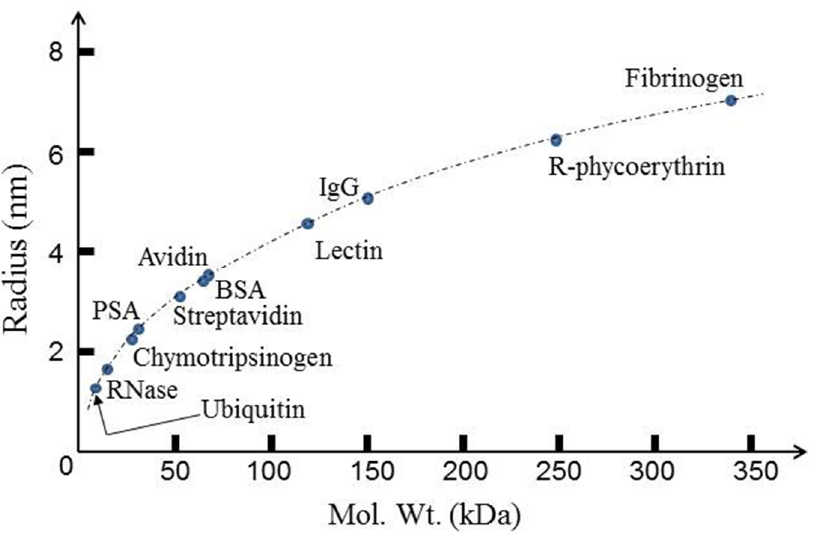
Figure 2. Globular proteins studied for their dielectrophoresis (DEP) response, with their hydrodynamic (Stokes) radii located on the empirical relationship between protein size and molecular weight (dotted curve) provided by Malvern Panalytical ® (Zetasizer Nano ZS).